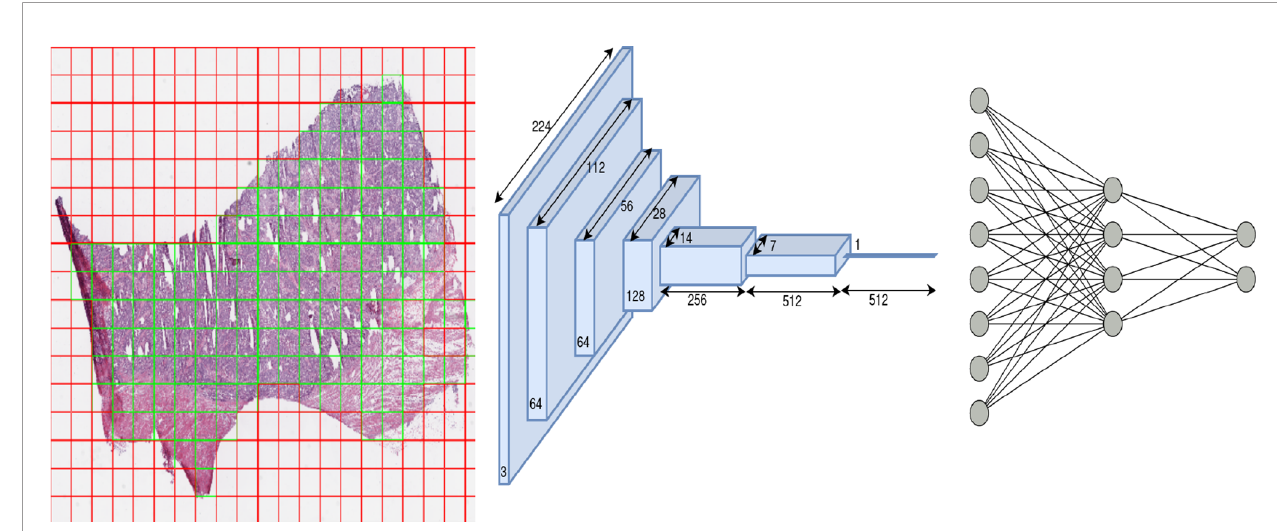
FIGURE 2 | Overview of architecture used in our work: patch extraction (left): red shows rejected background patches, and green shows patches used for the training model, ResNet-18 architecture (middle) and Fully connected network (right).